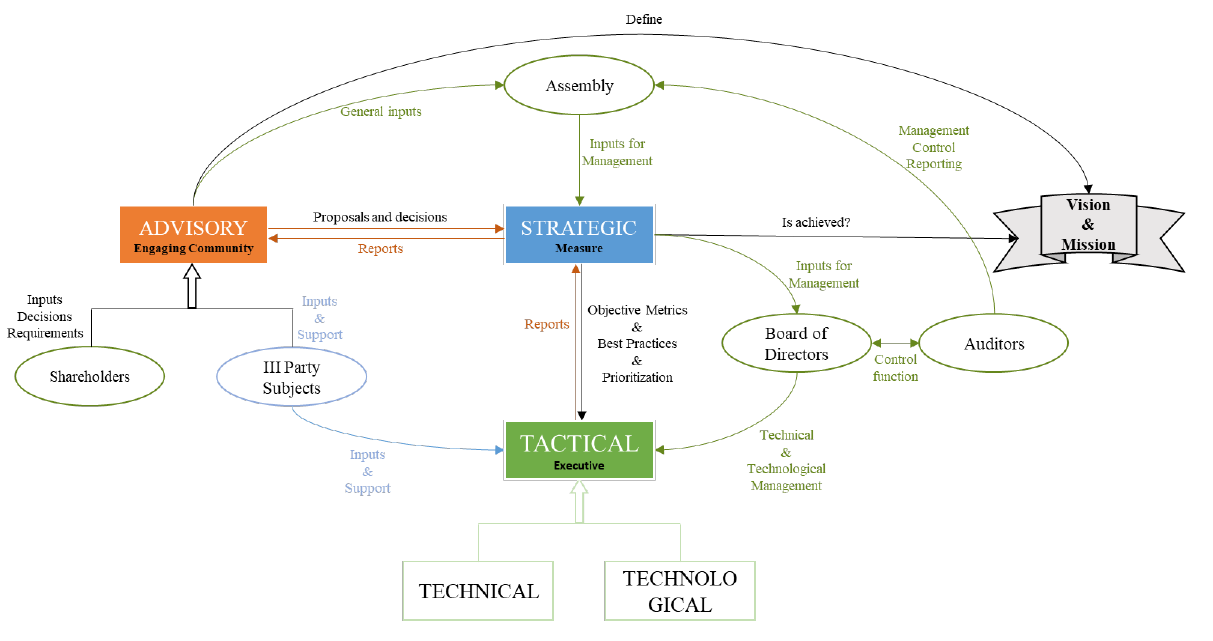
Figure 7. Governance model, information exchange, and bodies of the